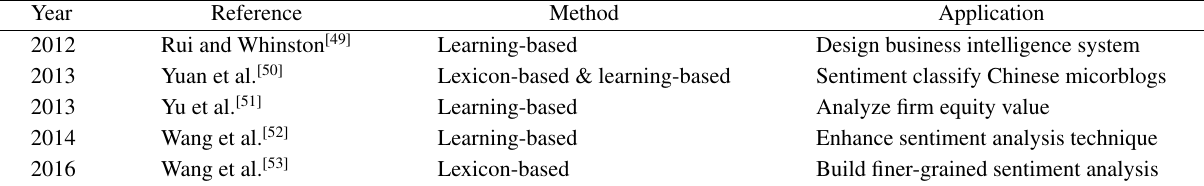
Table 3 Summary of previous works in sentiment analysis.